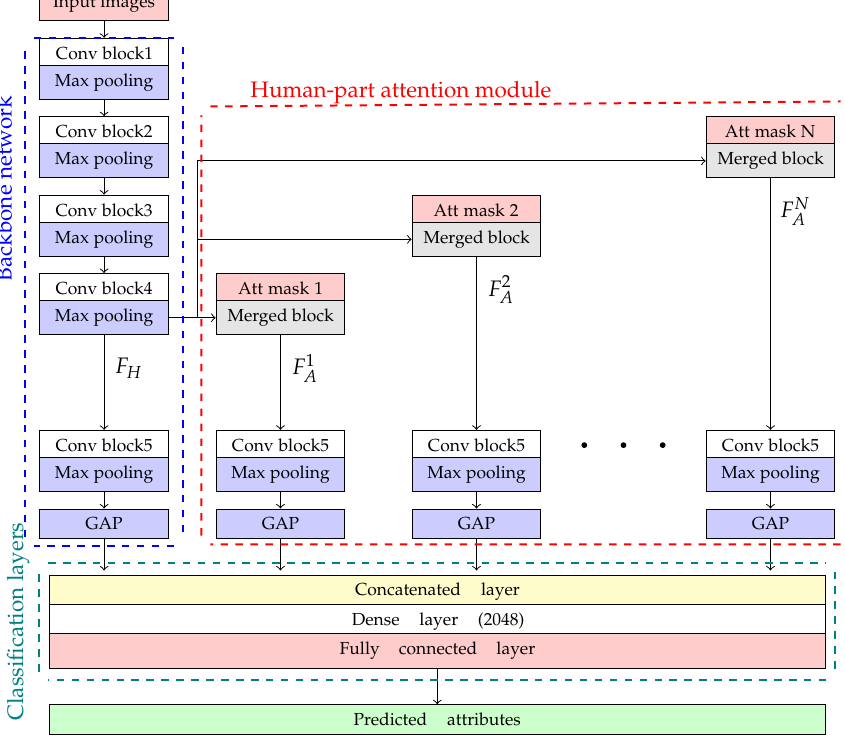
Figure 4. The proposed network architecture with a human-part attention